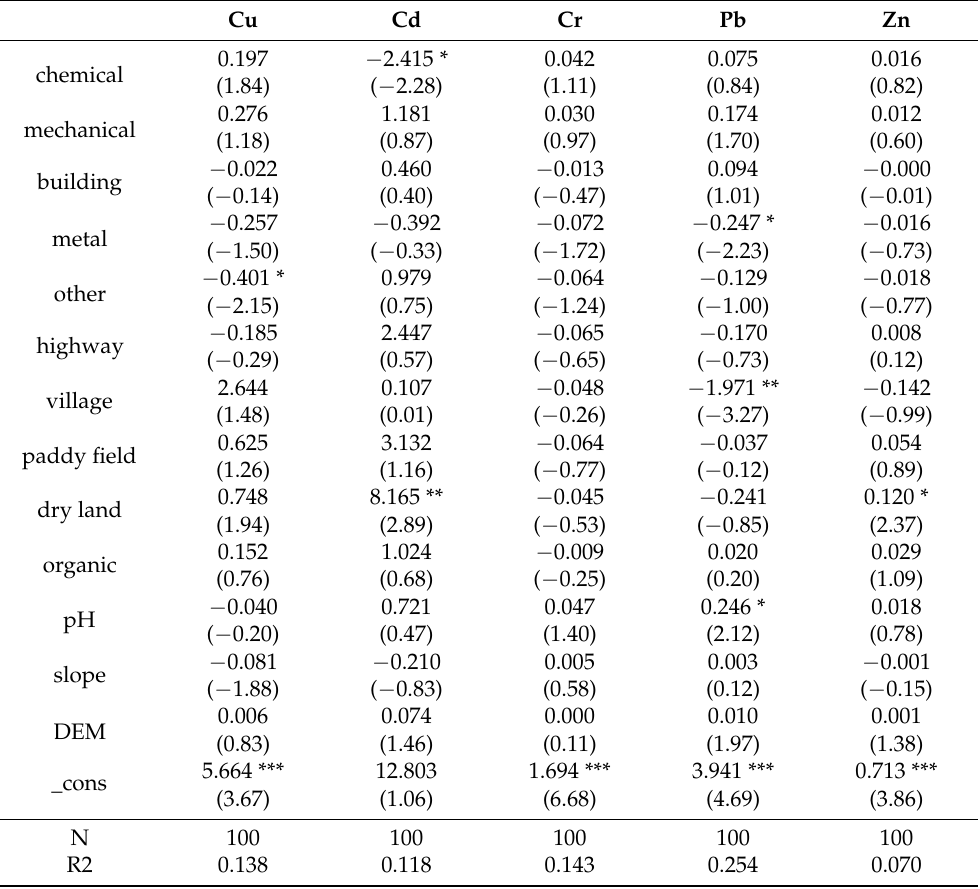
Table 9. Definition and descriptive statistics of